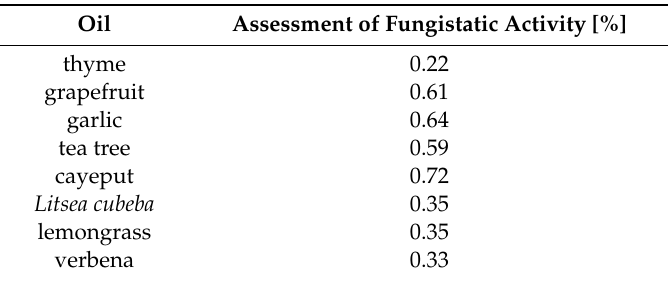
Table 10. Values of correlation coe ffi cients between the oil concentration and its fungistatic activity in relation to the four tested Fusarium isolates.